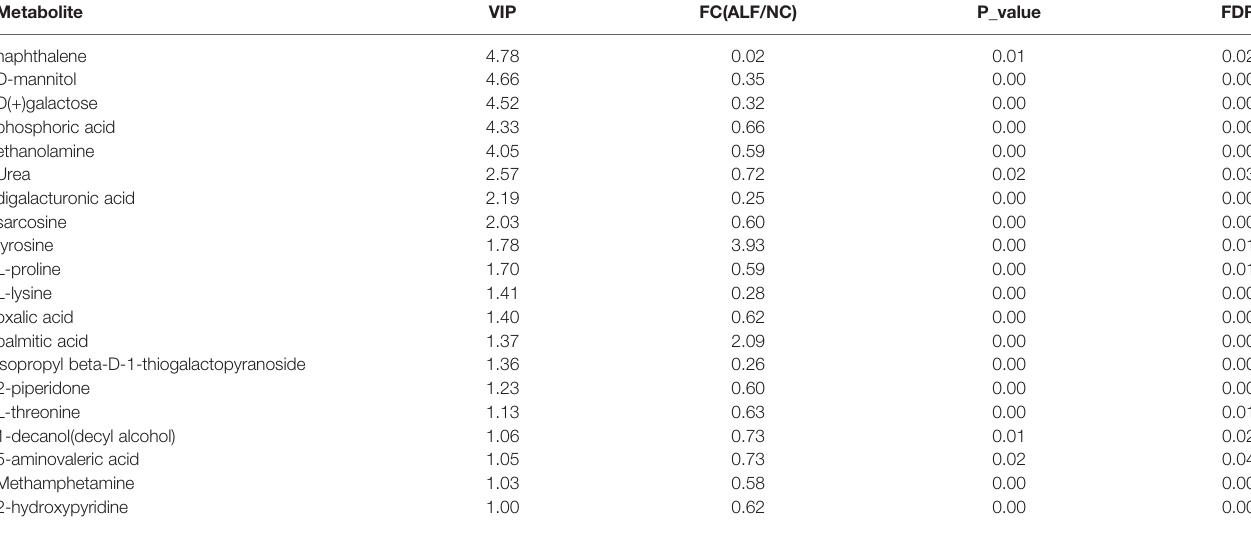
TABLE 1 | We found that 20 metabolites changed signi fi cantly between the normal control group and the ALF group (VIP > 1, FDR < 0.05, n = 6). Metabolite VIP FC(ALF/NC) P_value FDR